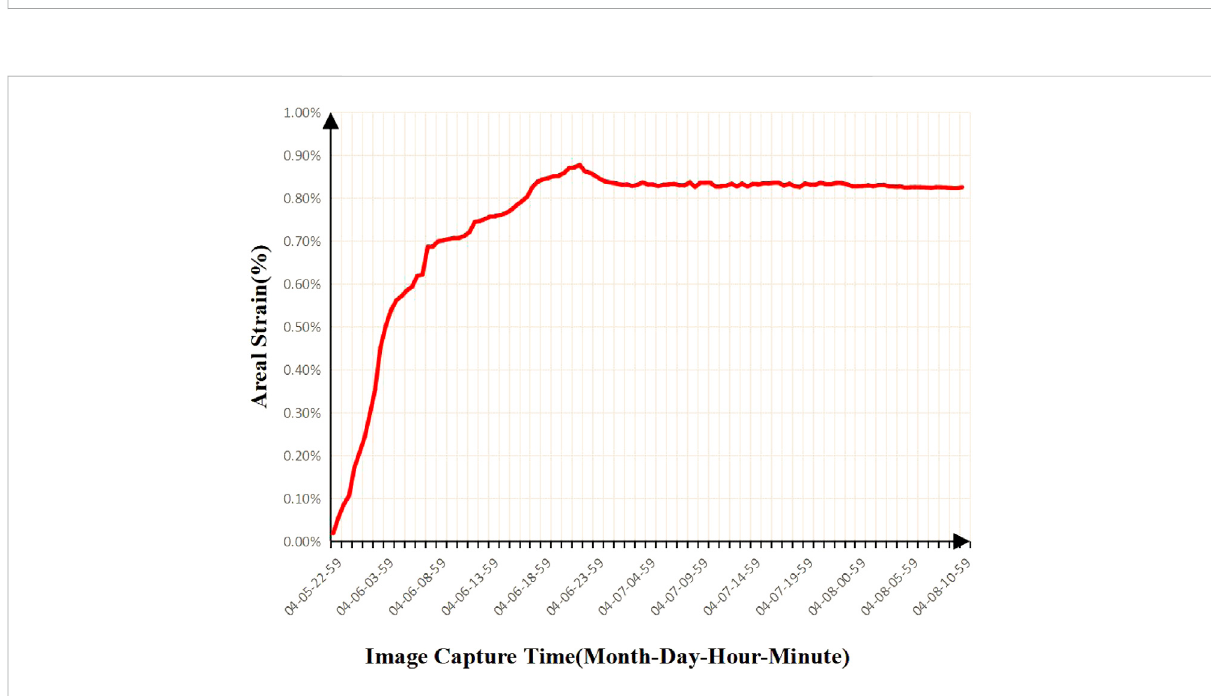
FIGURE 9 Results of time-dependent strain of ash coal fi lled with CO 2 adsorption